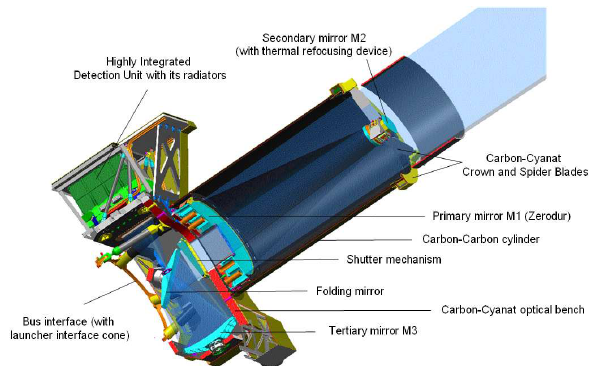
Figure 6: Optical architecture